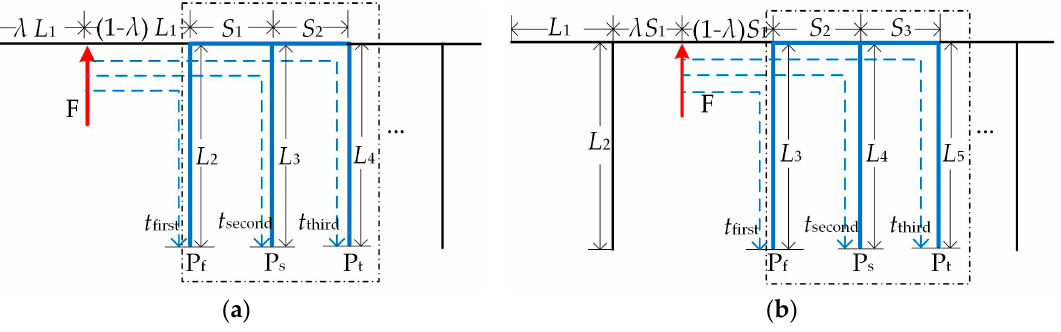
Figure 5. Situation of the first three arrival times detected from one direction. ( a ) Fault in a branch. ( b ) Fault in main line between two tap nodes.